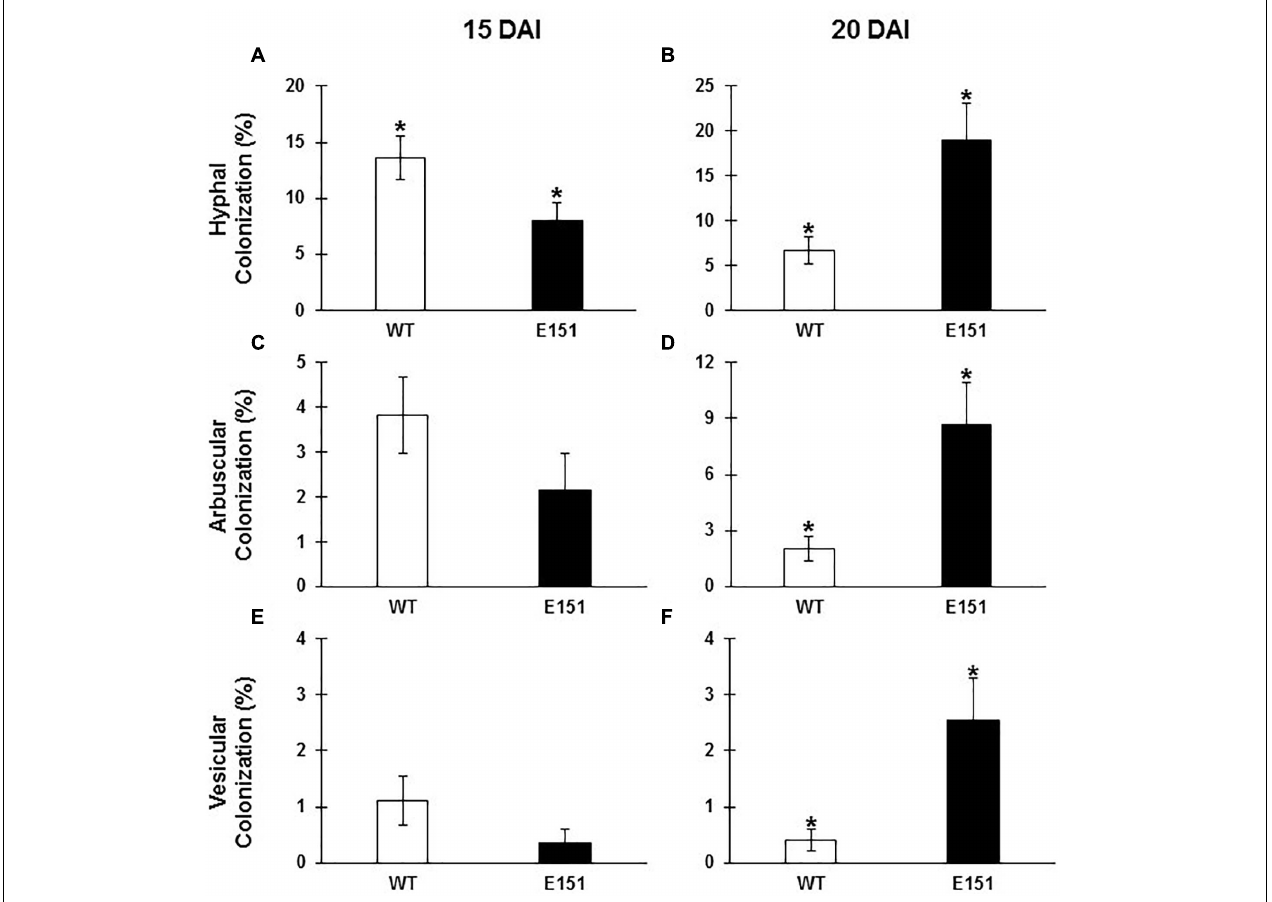
FIGURE 3 | Percent of WT (empty bars) and E151 (solid bars) roots colonized by R. irregularis , as determined by assessing percentages of intraradicular hyphae (A,B) , arbuscules (C,D) , and vesicles (E,F) observed at 15 (A,C,E) and 20 (B,D,F) DAI. These data (mean ± SE; n = 5 or 6) are the result of one replicate and are the best representative of three replicates; they were subjected to Student’s t -test to determine significant differences between pea lines. An asterisk indicates significance at a 95% confidence